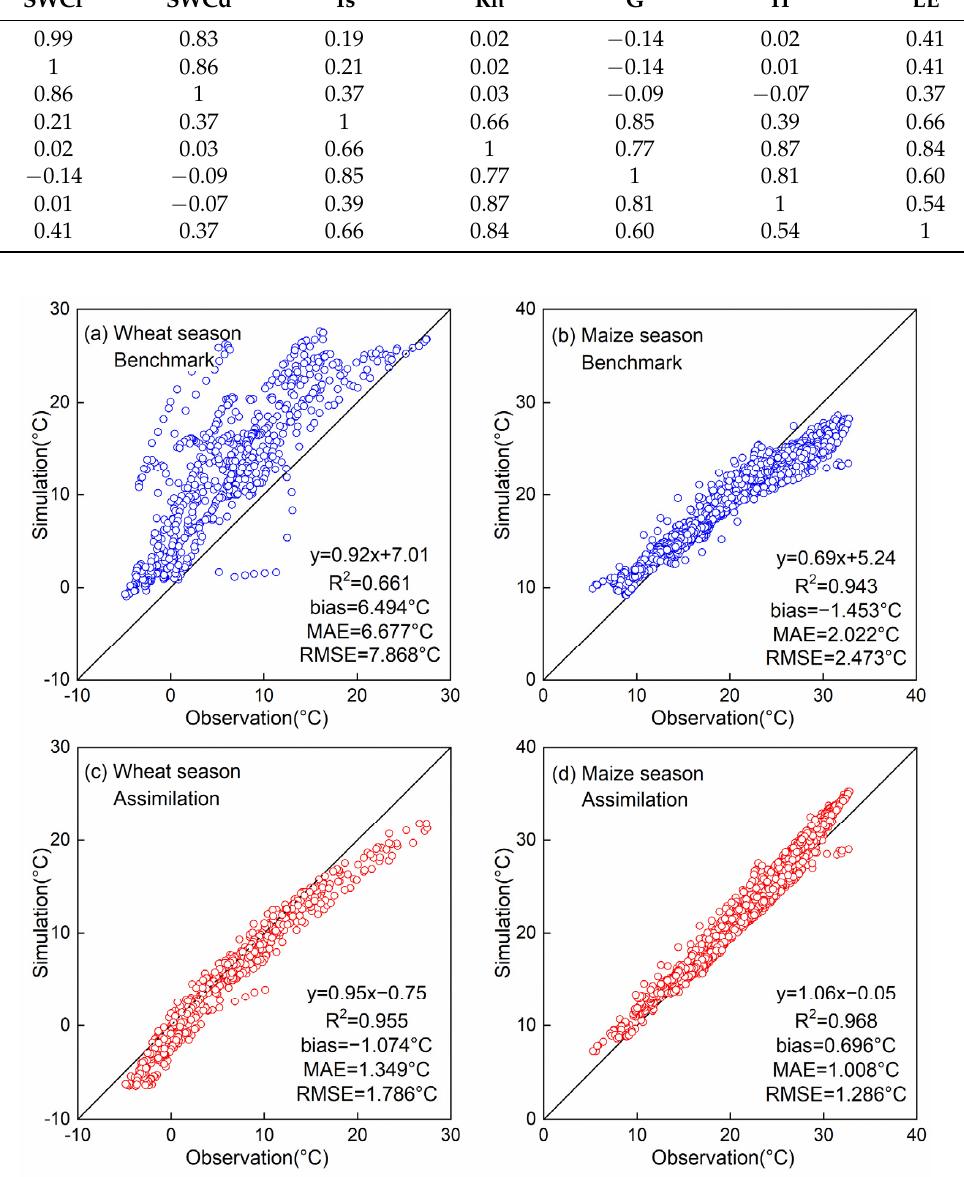
Figure 13. The scatter plot of Ts simulation compared with observation by benchmark run and da-ta assimilation ran.